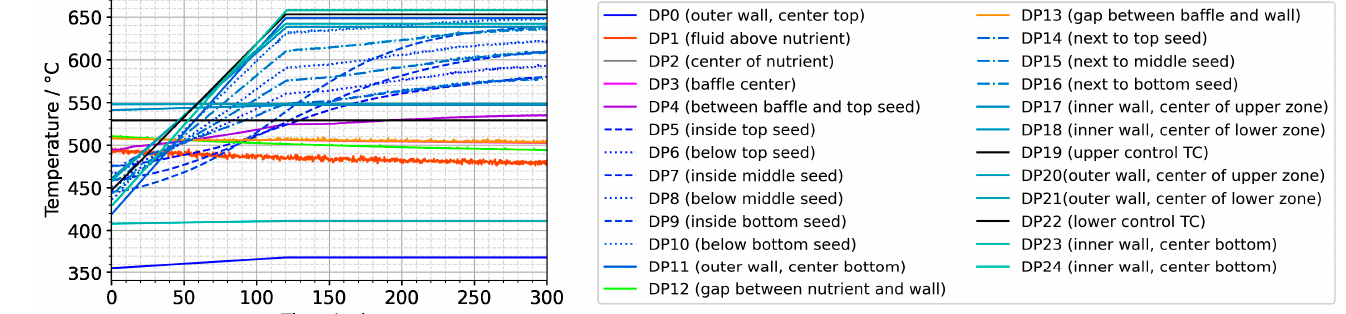
Figure 9. Temperatures over time for the entire set of domain probes.